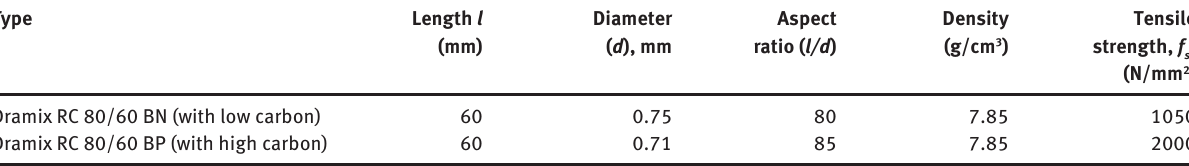
Table 1 Properties of hooked-end steel fibres used in this